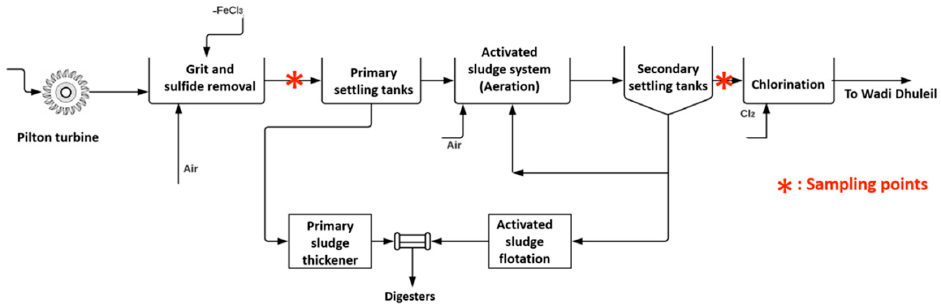
Figure 2. Process flow schematic of As-Samra WWTP and sampling points.